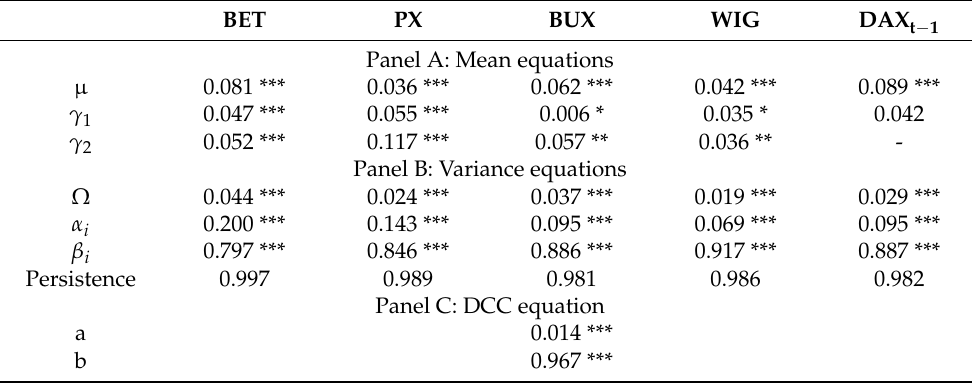
Table 2. Estimation results from the DCC-GARCH models (CEEC-Germany). BET PX